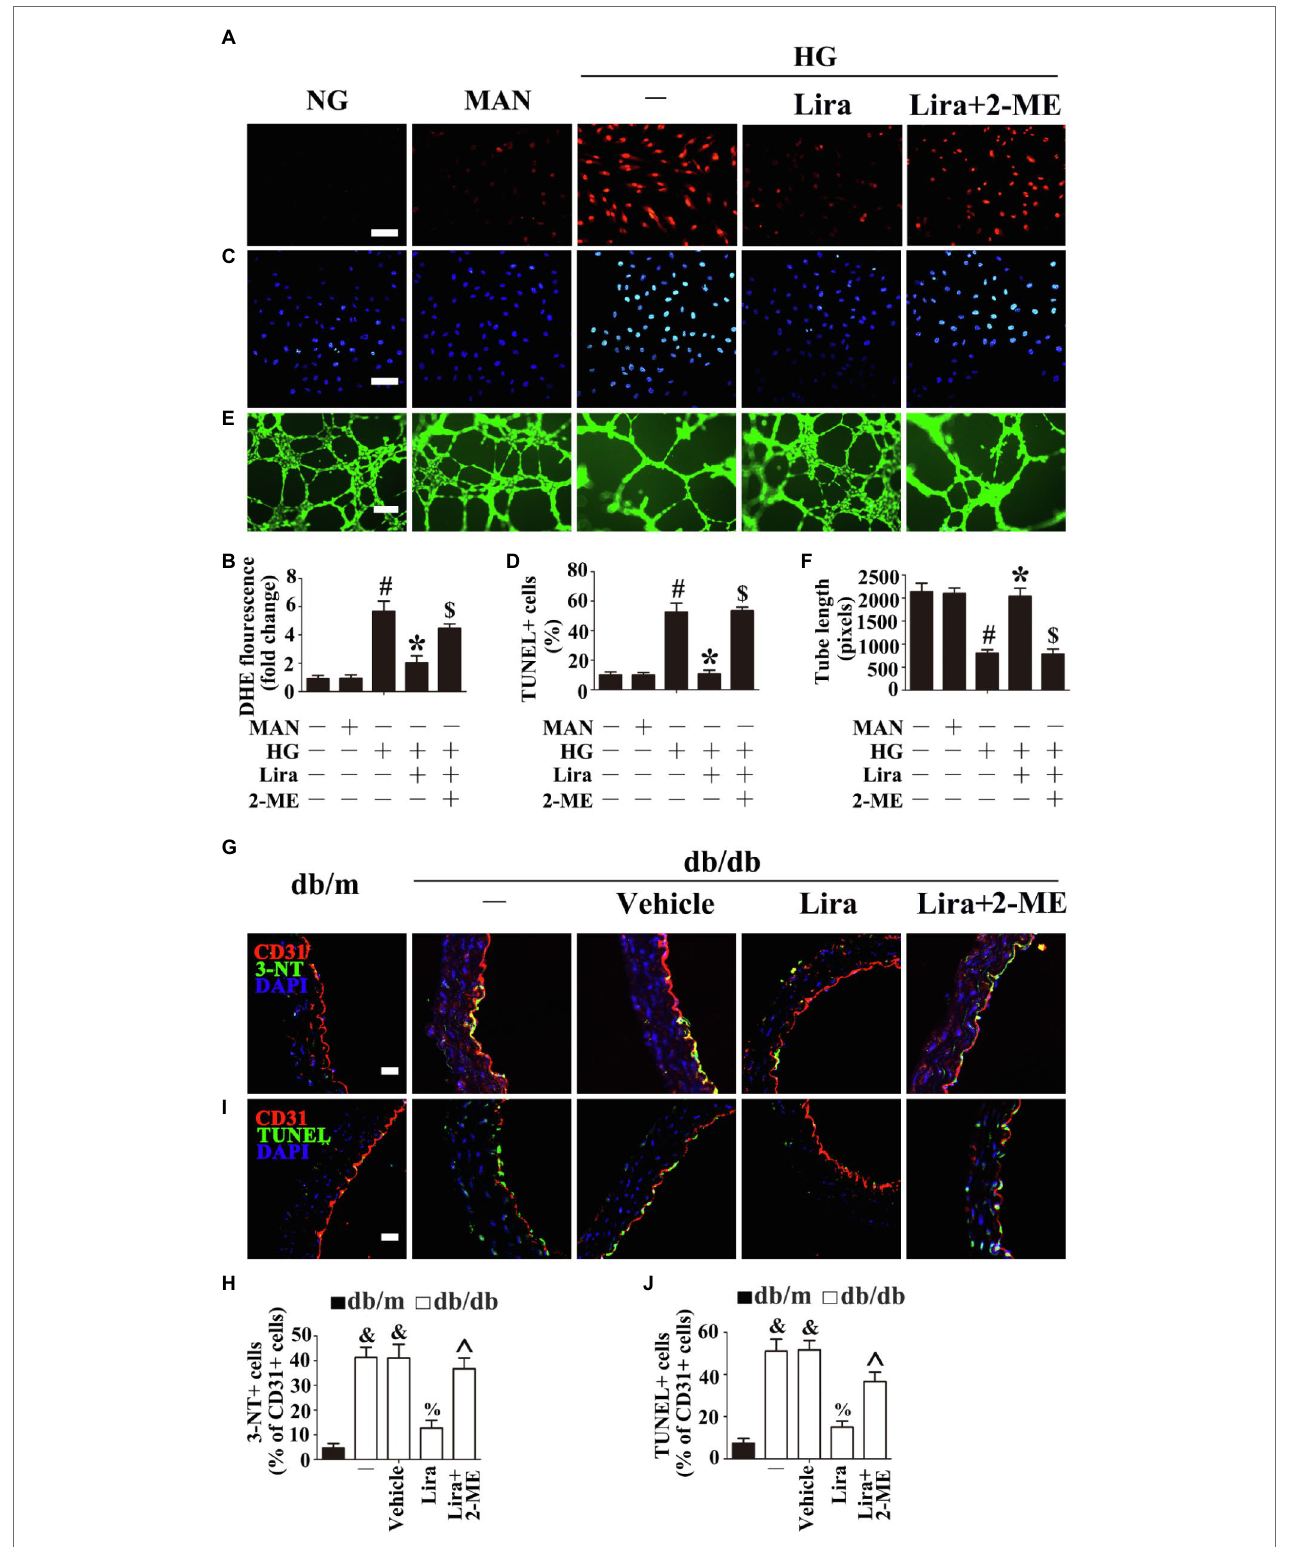
FIGURE 4 | Hif-1 α , as the downstream of AMPK, participates in the endothelial protective action of Lira against hyperglycemia, in vitro and in vivo . (A) Fluorescence with DHE, scale bars = 100 mm, (C) TUNEL assay, scale bars = 100 mm, and (E) capillary-like tube formation, scale bars = 300